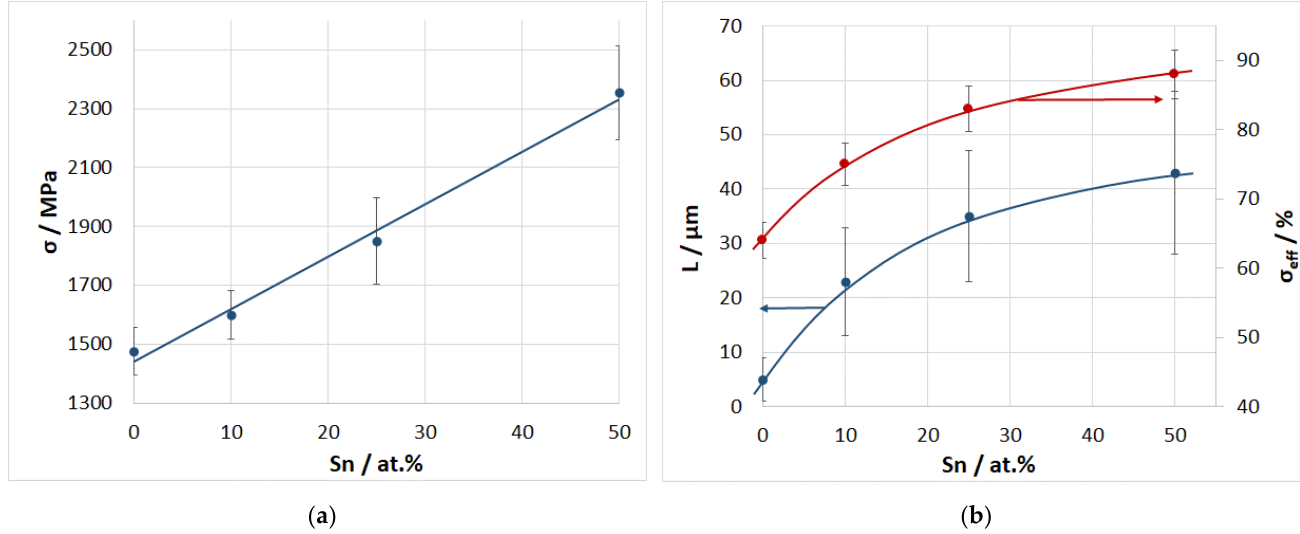
Figure 6. Dependence of the strength of a composite CF/Al-Sn wire subjected to three-point bending ( a ), effective fiber strength and length of the pulled-out part of the fiber at fracture ( b ) on the tin content.